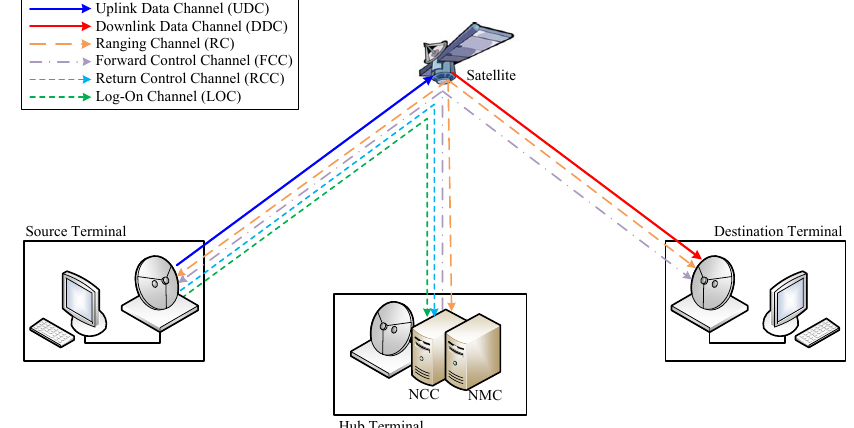
Figure 1. System model of the proposed design (link layer). NCC, network control center; NMC, network management